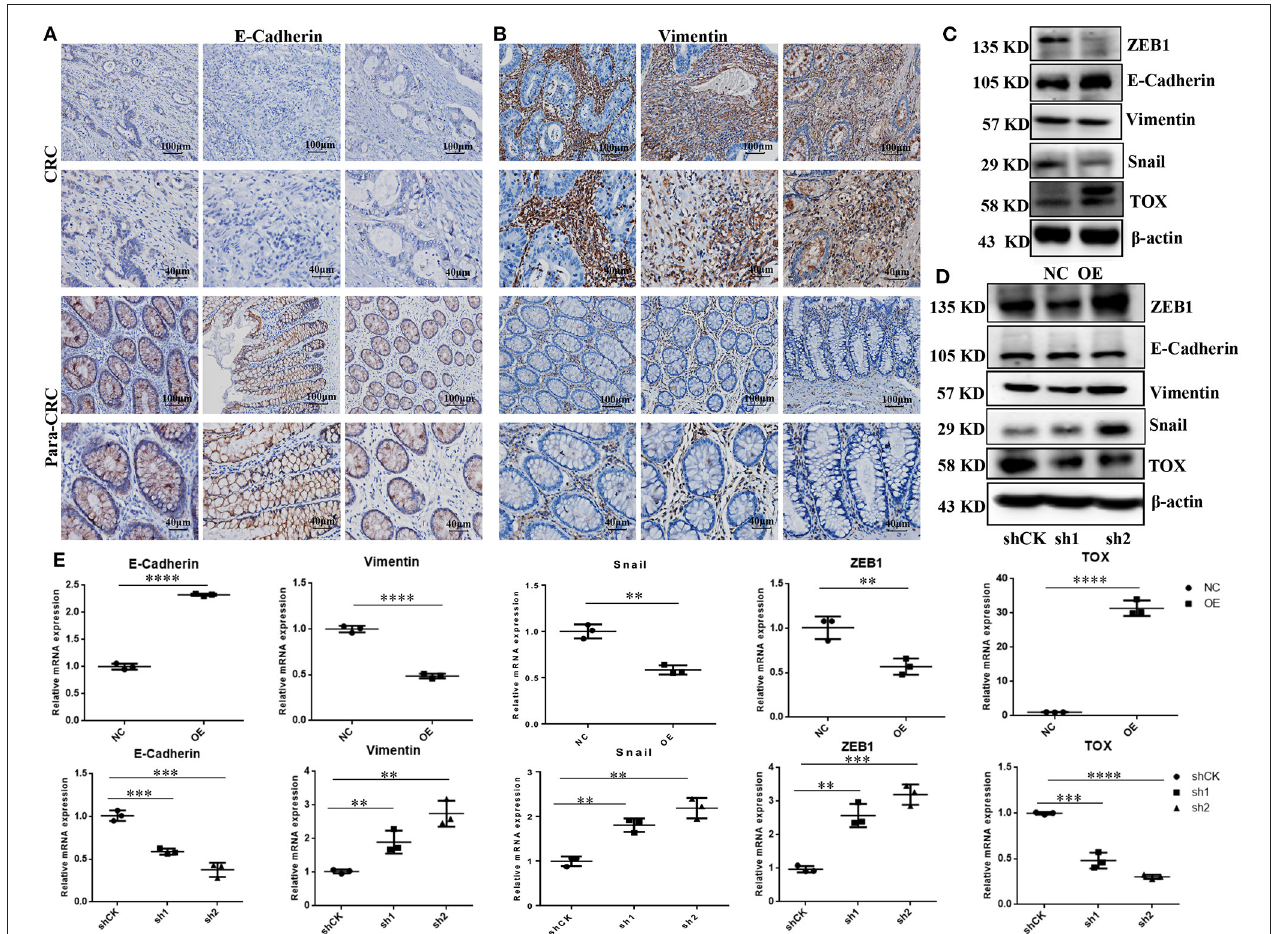
FIGURE 4 | TOX represses the EMT process. IHC shows assay E-cadherin (A) and vimentin (B) expression in CRC and para-CRC tissues ( n = 40). (C) Western blot shows EMT-related proteins ZEB1, E-cadherin, vimentin, and Snail expression in PLVX-Flag-TOX and PLVX-Flag SW1116 cells. (D) Western blot assay shows ZEB1, E-cadherin, vimentin, and Snail in shCK HCT116, shTOX-1 (sh1), and shTOX-2 (sh2) HCT116 cells. (E) qRT-PCR shows ZEB1, E-cadherin, vimentin, and Snail expression in PLVX-Flag-TOX, PLVX-Flag SW1116, shCK HCT116, shTOX-1 (sh1), and shTOX-2 (sh2) HCT116 cells. Each experiment was repeated three times. * p < 0.01,*** p < 0.001,**** p <